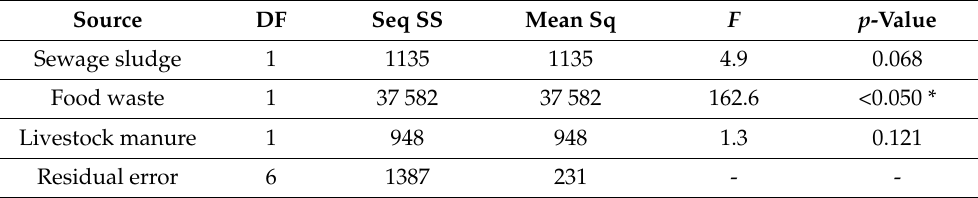
Figure 4. Normal probability distribution for cumulative methane yield. Table 7. Analysis of variance for cumulative methane production.